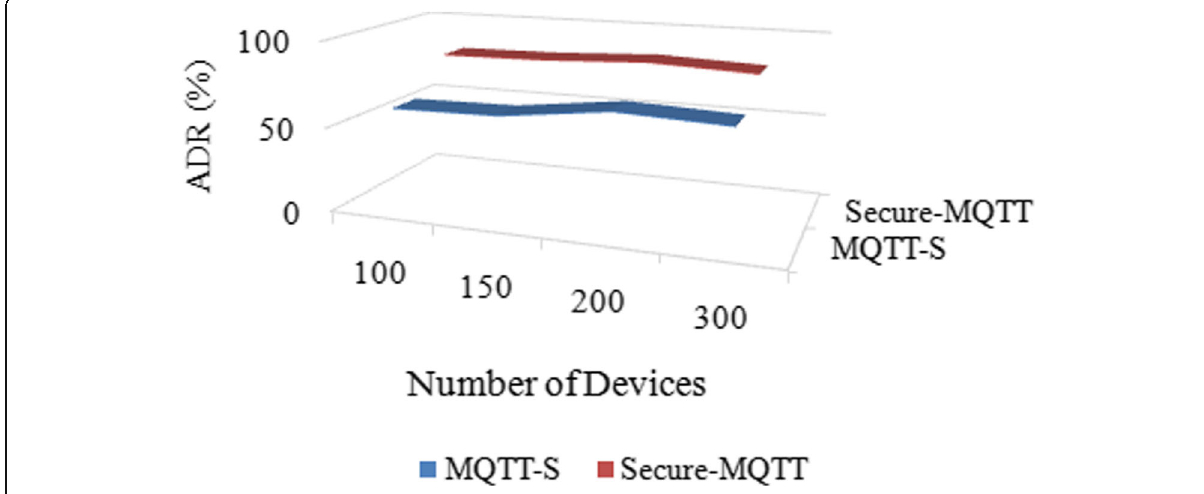
Fig. 11 ADR vs Number of devices in